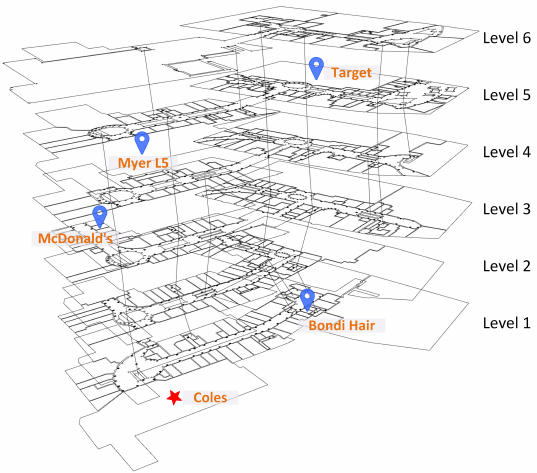
Figure 9. Departures and intermediate places in